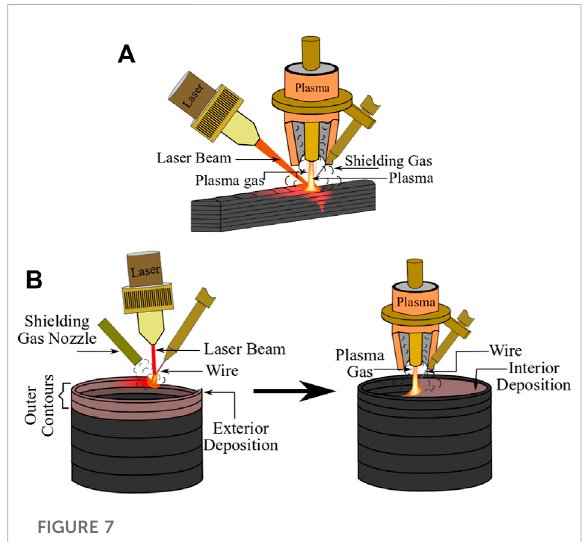
FIGURE 7 Laser-Plasma hybrid-deposition (A) laser-assisted TIG deposition and (B) feature-based laser and plasma